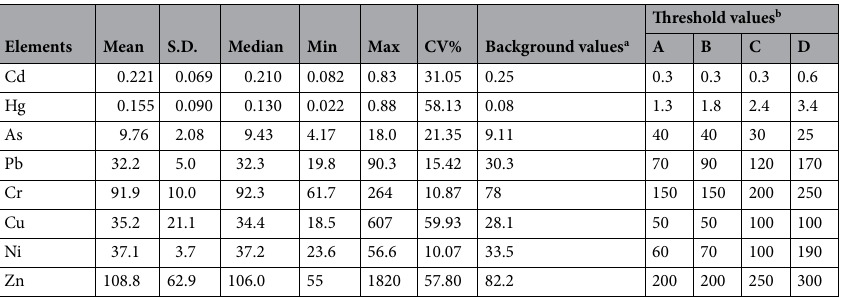
enriched to a certain extent in soil. The CV of the HMs in the agricultural soils increased in the order Ni(10.1%), Cr(10.9%), Pb(15.4%), As(21.4%), Cd(31.1%), Zn(57.8%), Hg(58.1%) and Cu(59.9%). The exceptionally high variability of Cu, Hg and Zn indicates that these metal(loid)s differed greatly with respect to different sites, and the existence of abnormally high values is the main reason that the CV was high. It further indicates that Cu, Hg